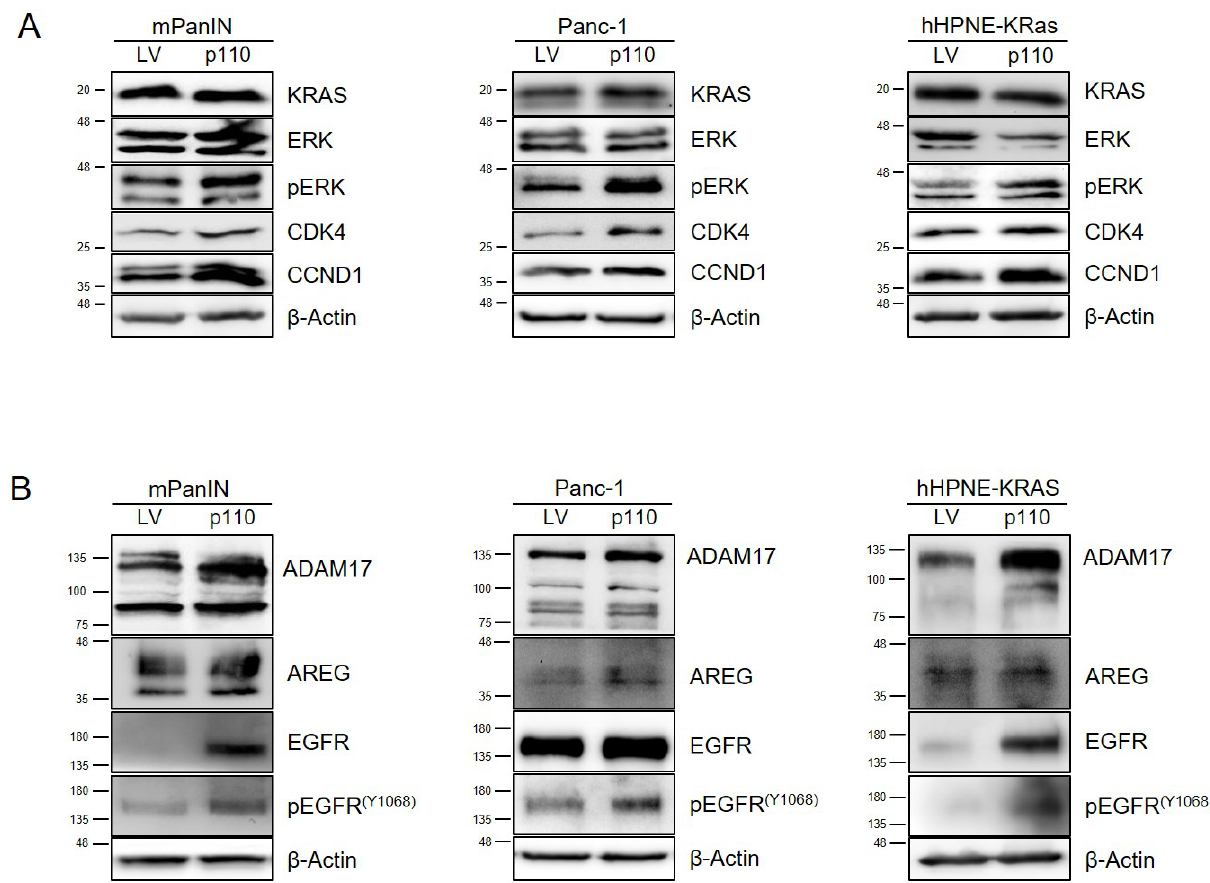
Figure 6. p110 CUX1 potentiates proliferation via upregulation of ADAM17 and increased EGFR activation in KRAS-mutant pancreatic cell lines. ( A , B ) Western blot analysis of whole protein cell lysates from stable transduced mPanIn, Panc-1 and hHPNE-KRas cells. Actin served as control. ( A ) Overexpression of p110 potentiated the protein levels of the cell proliferation markers pERK, CDK4 and CCND1 compared to empty vector (LV) control cells. Phosphorylated ERK and total ERK were determined using specific antibodies. ( B ) Compared to empty vector (LV) control cells, overexpression of p110 was associated with increased protein levels of total EGFR and phosphorylated EGFR (Y1068), as well as ADAM17, an EGFR ligand sheddase. Phosphorylated EGFR and total EGFR were determined using specific antibodies. The uncropped Western Blot images can be found in Figure S9 and the densitometry analysis can be found in Figure S10.